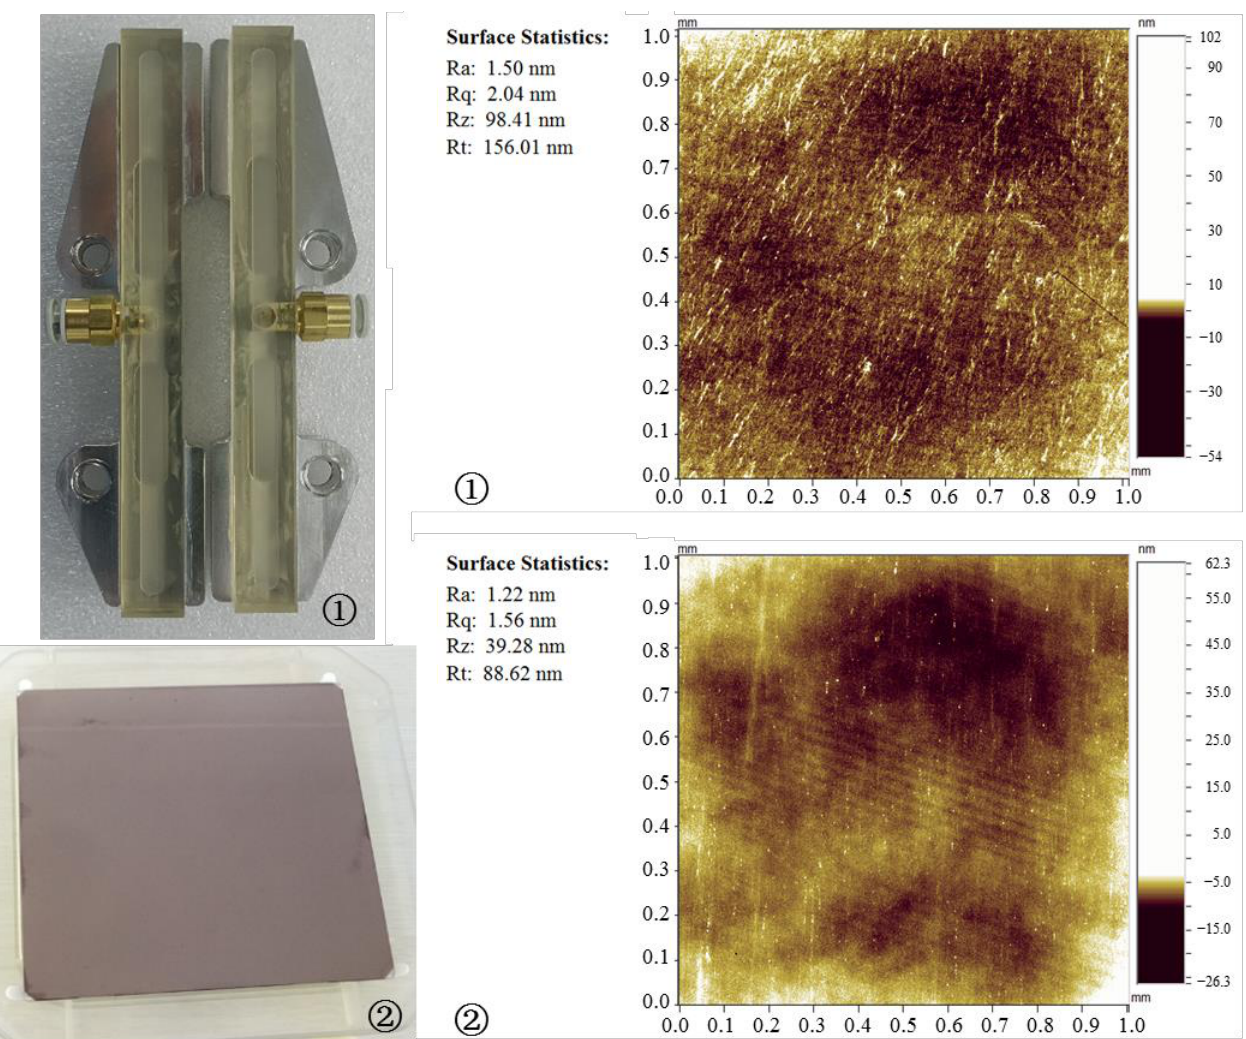
Figure 7. Reticle and chuck and their surface morphology. ① represents the fused quartz surface of the chuck, and ② represents the quartz ceramic surface of the reticle.